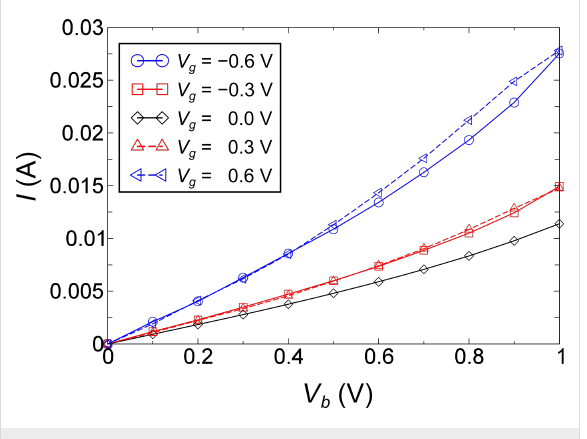
Figure 2: Current–Voltage ( I − V b ) curves at different V g .